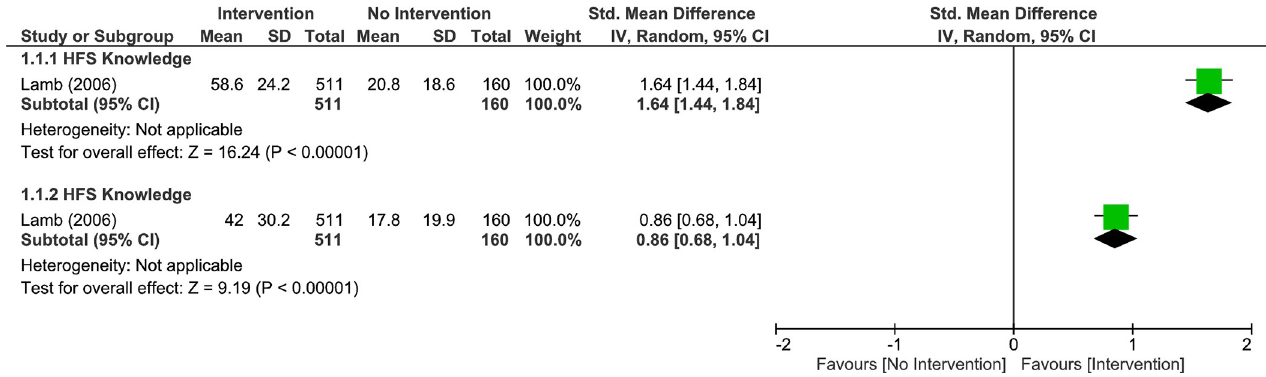
Fig 4. Analysis 4.1.1 forest plot of comparison: Intervention vs no intervention, immediate–primary school children, outcome: Home fire safety knowledge, 1 study. Analysis 4.1.2 Forest plot of comparison: Intervention vs No Intervention, 3 months–Primary School Children, outcome: Home Fire Safety Knowledge, 1 study. Higher values indicate better/improved outcome.